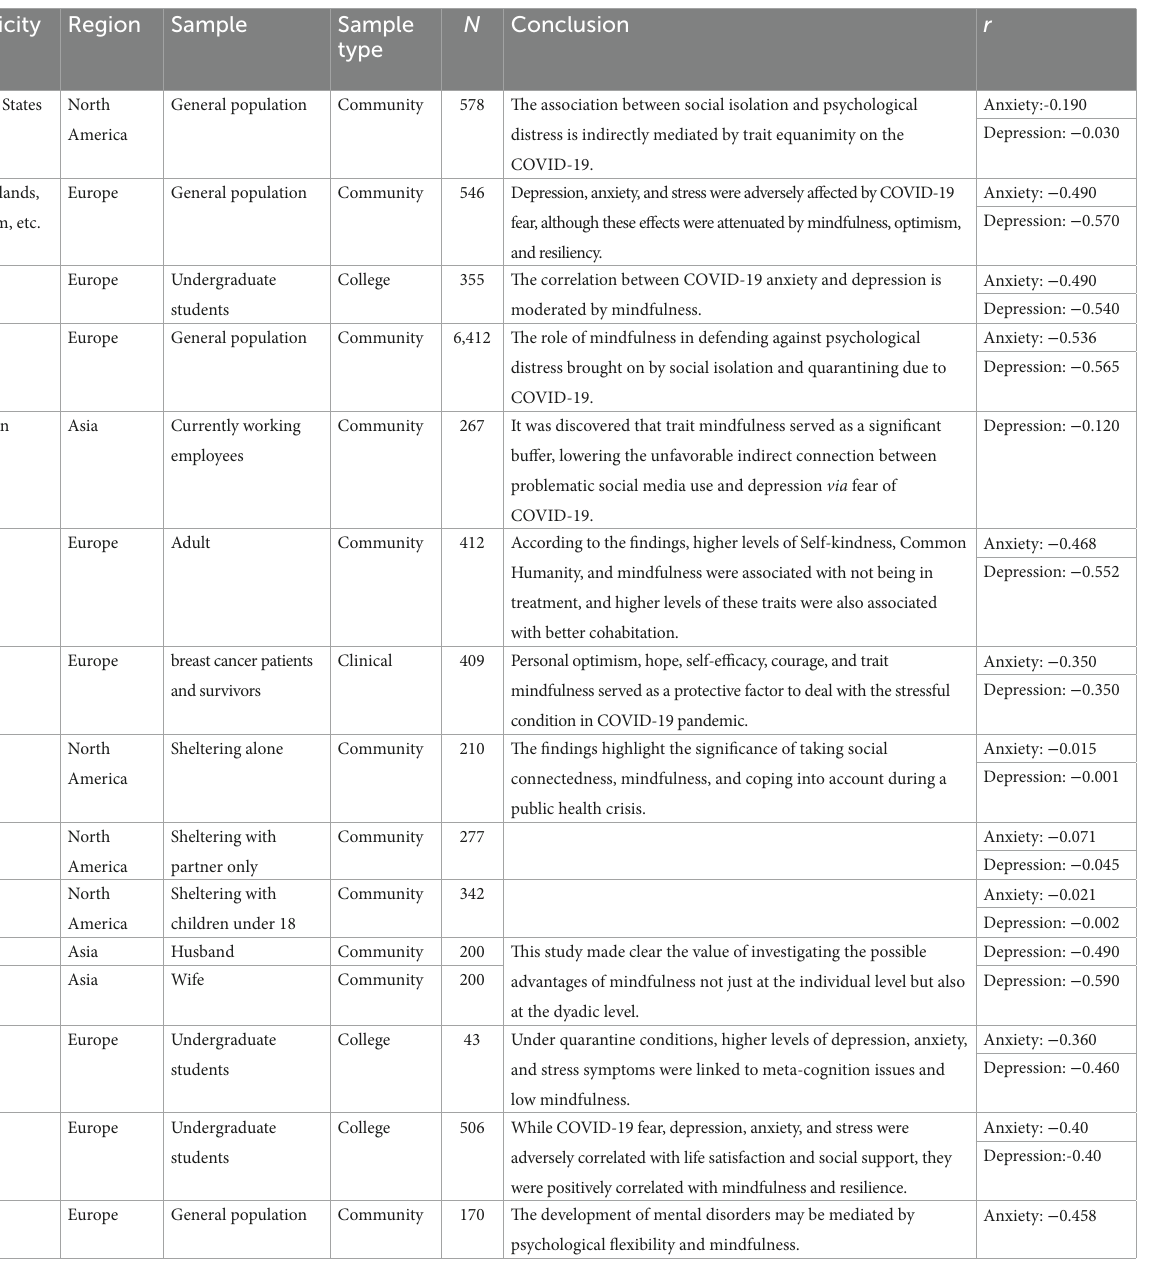
TABLE 1 The characteristics of selected